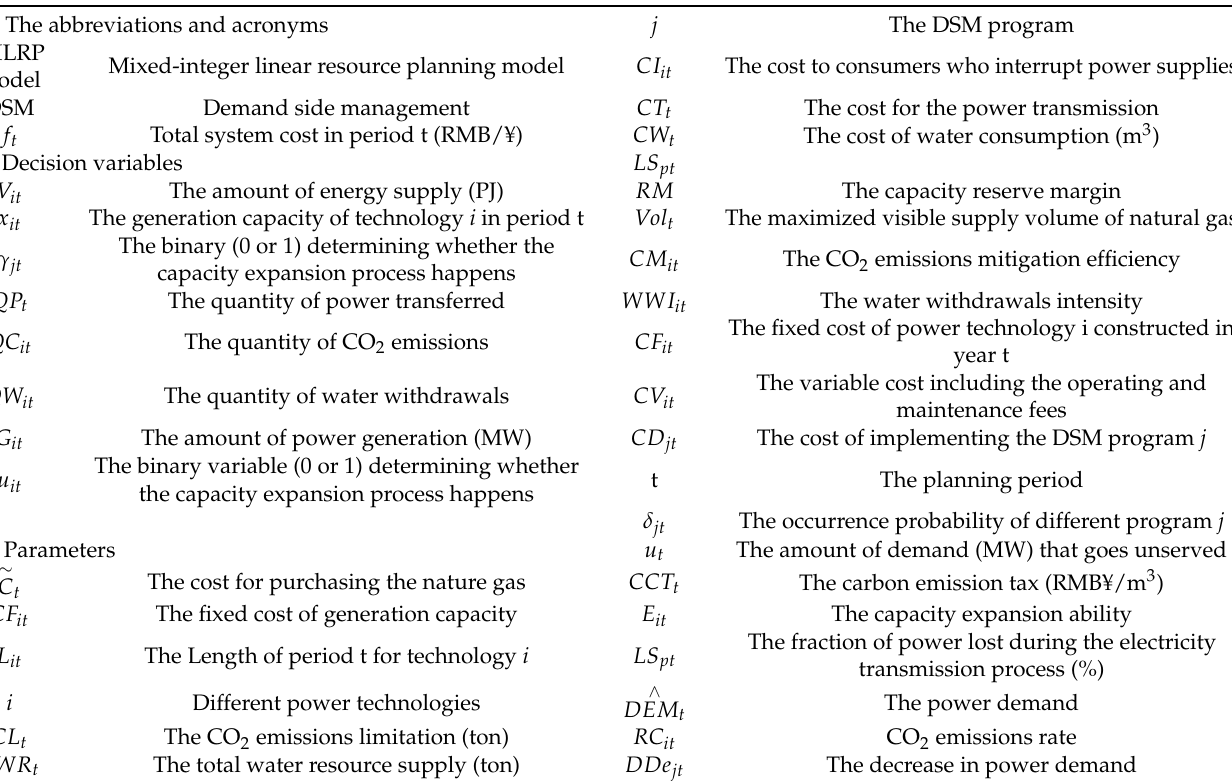
Table 1. The decision variables and parameters of the MILRP